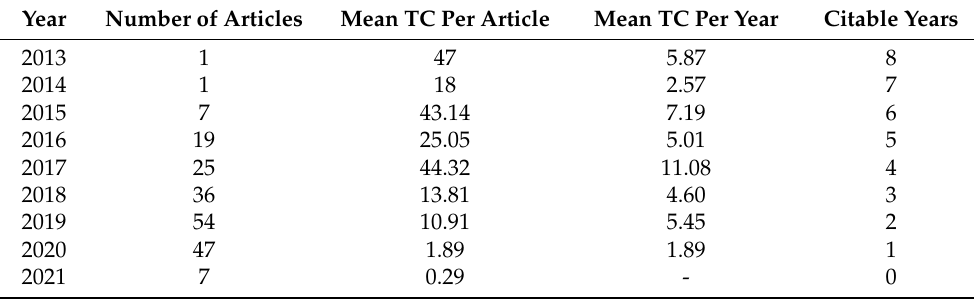
Table 2. Number of articles and means of citations per article and year.